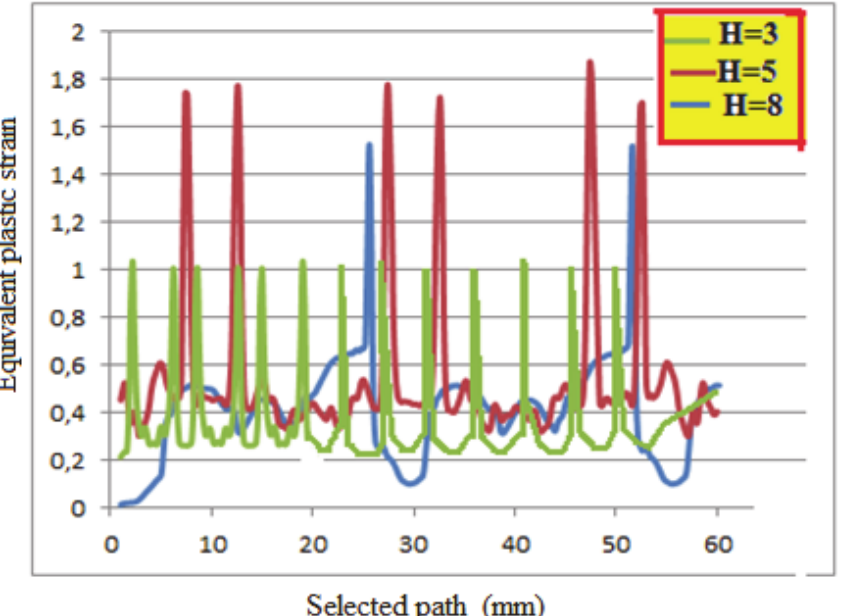
Figure 20: Evolution of the equivalent plastic deformation along a path on the lower surface, using different groove depths Fig. 21 summarizes the different results of the maximum values of equivalent plastic strain for different depth values of the groove. It can be noted that the highest values are obtained at the lower and upper surfaces with a depth H = 5 mm while the lowest values are obtained in the middle of the sample. For this surface the maximum equivalent strain is obtained by a groove with depth of 8